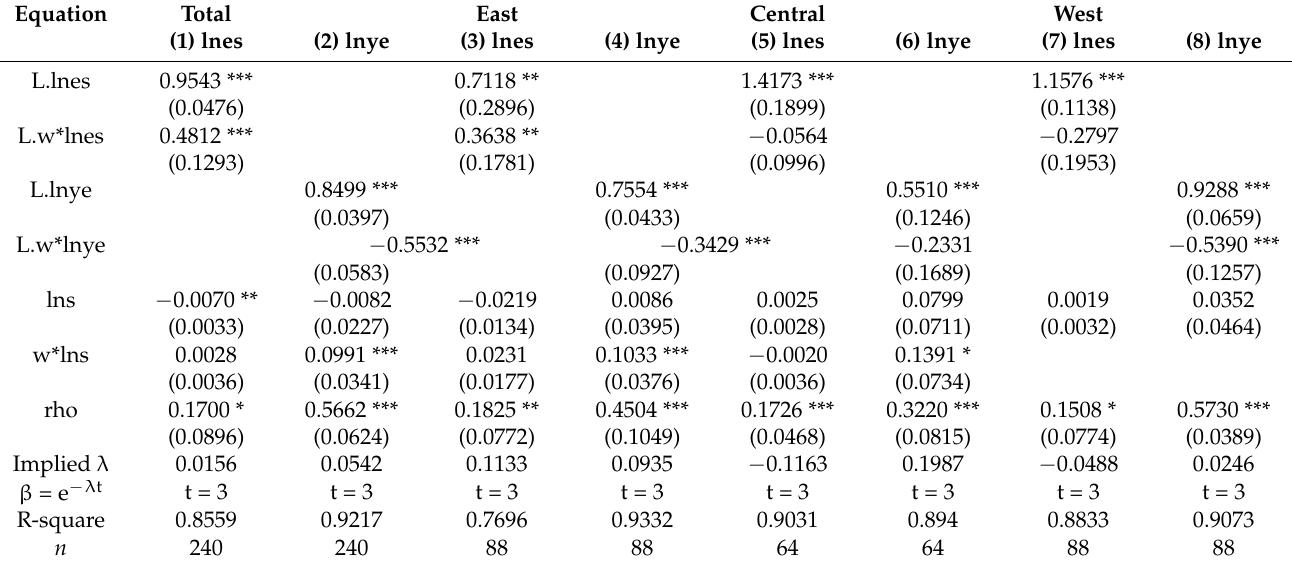
Table 7. Test of Convergence Mechanism for Spatial Dynamic Panel